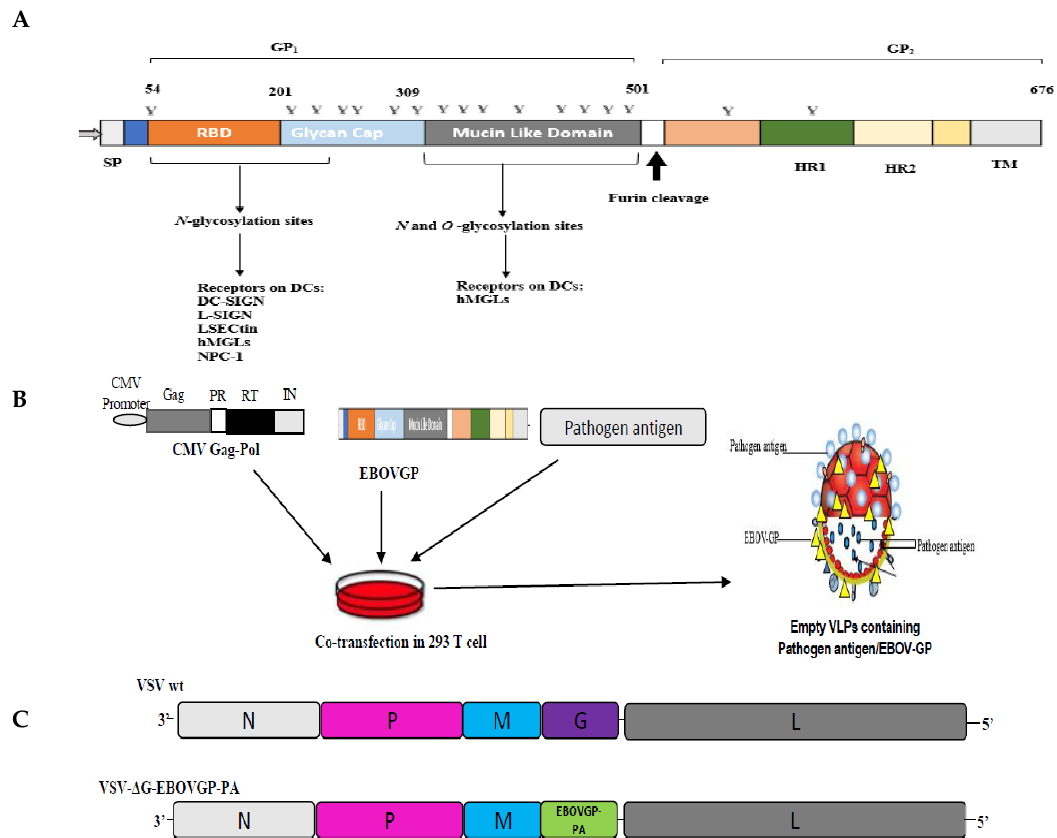
Figure 1. A schematic structure of ( A ) EBOV GP, indicating GP 1,2. GP 1 comprised of RBD, glycan cap, and MLD, while GP2 contains the HR1 and HR2. Y denotes the N-glycosylation sites. Receptors on DCs have an affinity with the N-linked glycans on GP 1 , indicating that the binding sites of EBOV GP with DCs are on the RBD, while the glycan cap contributes to its binding because of the presence of N - glycosylation sites [109]. The receptors on DCs for GP 1 include DC-SIGN [110], L-SIGN, LSECtin [111], hMGLs [112,113], and NPC-1 [114]. Although N-glycosylation sites are present on the MLD, MLD is dispensable, and its absence contributes to more efficient cell entry of EBOV GP [115]. ( B ) Schematic diagram showing the incorporation of EBOV GP with a different pathogen antigen into VLPs [115]. ( C ) Schematic structure of vesicular stomatitis virus (VSV) with deleted glycoprotein and having EBOV GP with different pathogen antigen in the deleted G domain of VSV [116]. (N , nucleoprotein; M , matrix protein; L , RNA polymerase; G , glycoprotein; P, phosphoprotein) The MLD is found on the variable region of GP 1 (C-terminal) and increases the permeability of EBOV into the blood vessels, and also masks the cell from the innate immune response by obstructing access to the epitope of GP [117,118]. MLD can also shield the cellular surface protein sterically, causing cell damage, leakage of an explanted blood vessel, rounding and detachment of cell, and loss of physiological functions [119–121]. A study showed that the MLD blocks access to the surface MHC I and II, which leads to decrease in CD 8 + cells and consequently leads to cell rounding (cytopathic effect), while the removal of MLD uncovers the epitope of GP to induce neutralizing antibodies [120,122]. Another study also checked for the impact of EBOV GP without MLD (EBOV GP ΔMLD ) on the stimulation of anti-GP and neutralizing antibodies; this study revealed that EBOV GP ΔMLD elicits more anti -EBOV GP antibody than EBOV GP VLP, with moderate stimulation of neutralizing antibodies [107], indicating that MLD is dispensable for EBOV attachment. Our study also showed that the removal of MLD from EBOV facilitates the cell entry efficiently more than the wild type; however, EBOV GP wild- type stimulated NFκB than EBOV GP with deleted MLD [115].